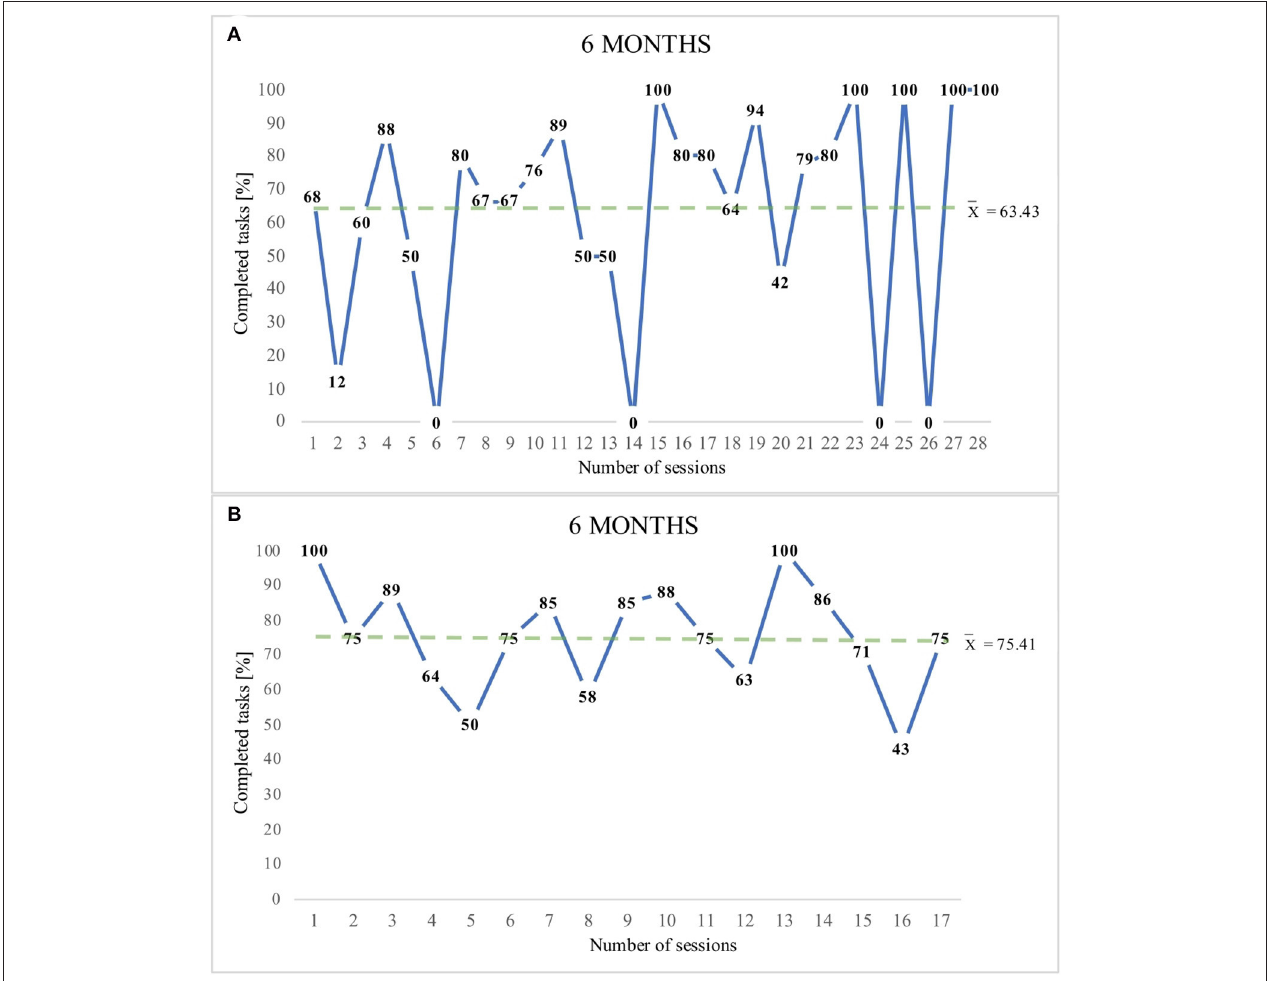
FIGURE 3 | Patient 3- graph (A) and Patient 4- graph (B) (6 months of work with the device).